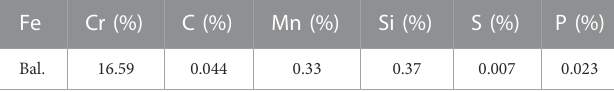
TABLE 1 Composition of SS430L ferritic stainless steel